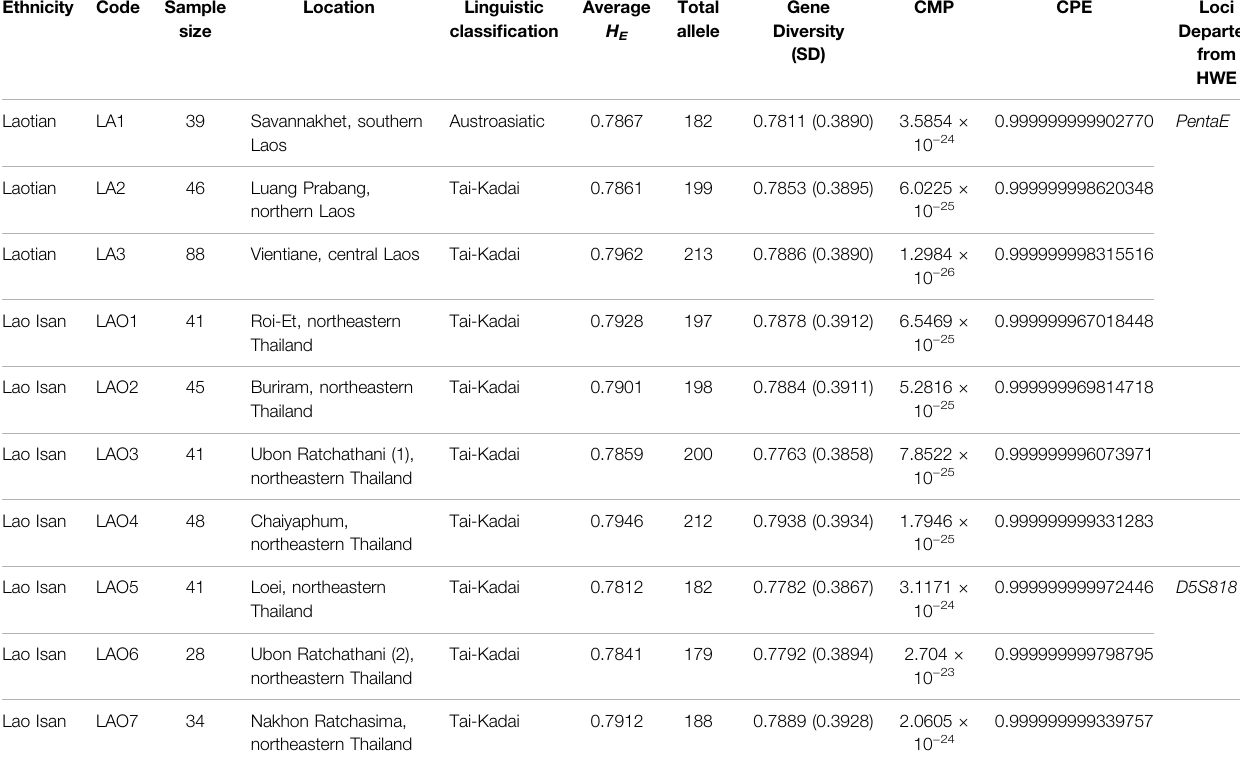
TABLE 1 | General information of the studied populations, genetic diversity indices and forensic parameters. Ethnicity Code Sample